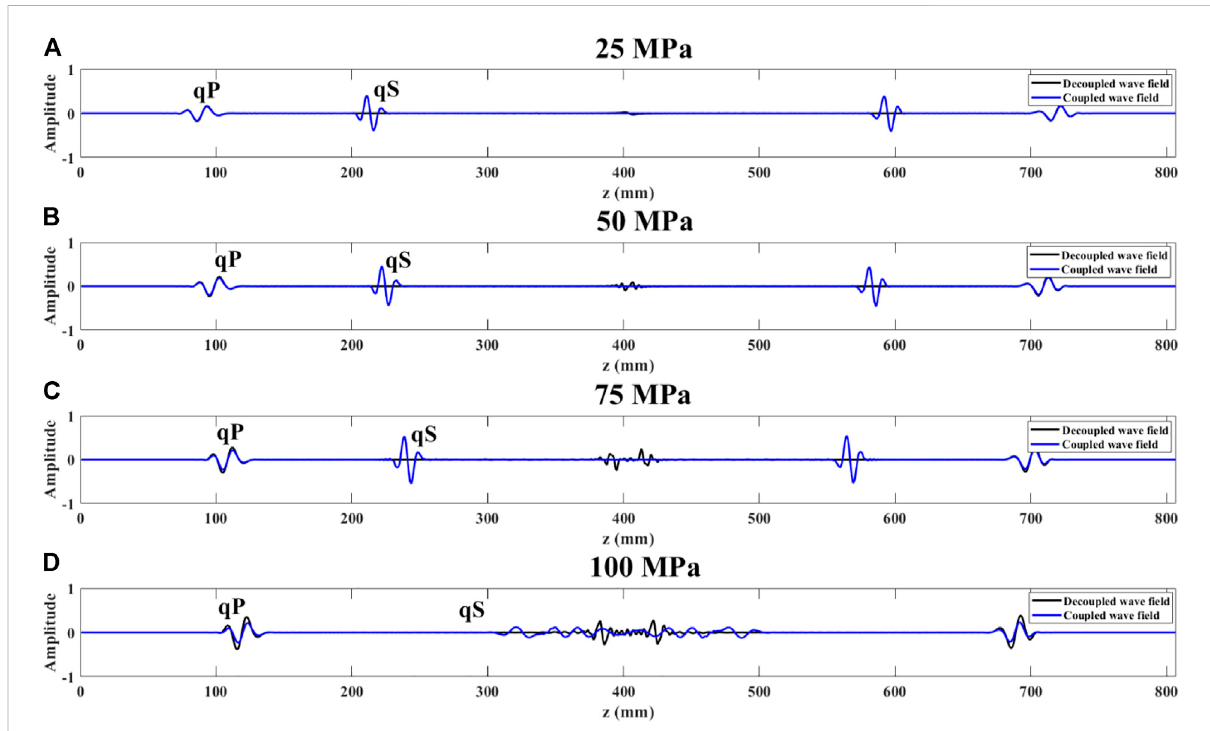
FIGURE 9 Records of x = 350 mm in snapshots above for various uniaxial stresses ( (A) : 25 MPa; (B) : 50 MPa; (C) : 75 MPa; (D) : 100 MPa). (The black solid lines indicate records of decoupled wave fi eld; the blue solid lines denote records of coupled wave fi eld).